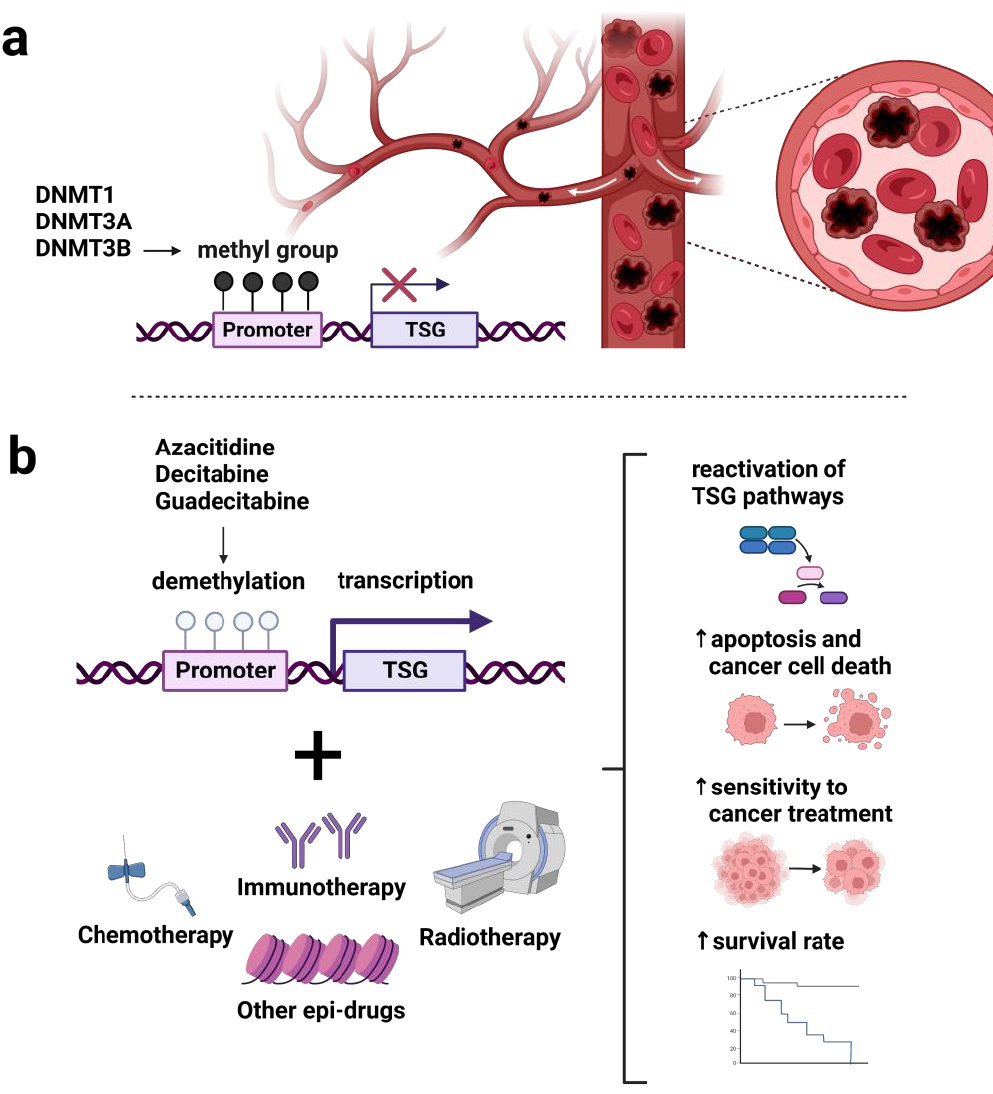
Figure 3. Clinical significance of combined treatment with hypomethylating agents and other thera- pies in hematologic cancer patients. DNA methyl transferases DNMT1, DNMT3A, and DNMT3B mediated DNA methylation resulting in aberrant gene silencing. In hematologic cancers, aberrant DNA methylation cause changes in the function of tumor suppressor genes, which play a role in cancer-associated pathways ( a ). Epi-drugs, including first-generation azacitidine, decitabine, and second-generation guadecitabine, are used as DNA methylation inhibitors in leukemias, myelodys- plastic syndromes, and lymphomas. HMAs aim to reactivate silenced genes subsequently involved in apoptotic, repairing, and angiogenic pathways. Recently, a strategy of combined treatment with HMAs and dose-specific chemotherapy/immunotherapy/radiotherapy and other epi-drugs repre- sents unique challenges in patient outcomes ( b ). Abbreviations: DNMT1, DNA methyl transferase 1; DNMT3A, DNA methyl transferase 3A; DNMT3B, DNA methyl transferase 3B; HMAs, hypomethy- lating agents; TSG, tumor suppressor